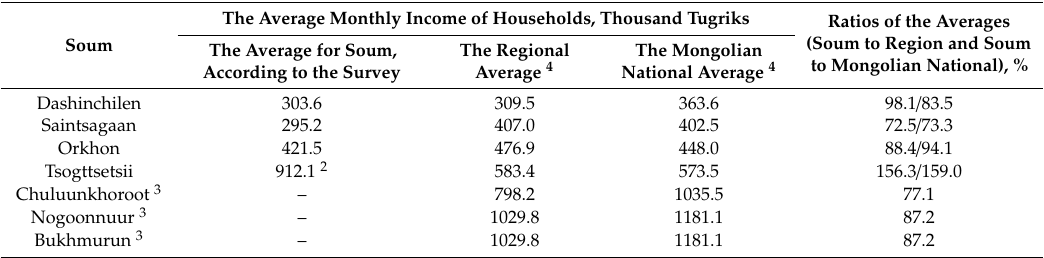
Table 3. The average monthly income of households in the model areas in comparison with the regional and Mongolian averages (according to national statistics), thousand tugriks 1 . The Average Monthly Income of Households, Thousand Tugriks Ratios of the Averages (Soum to Region and Soum Soum %The Average for Soum, The Regional The Mongolian to Mongolian National), According to the Survey Average 4 National Average